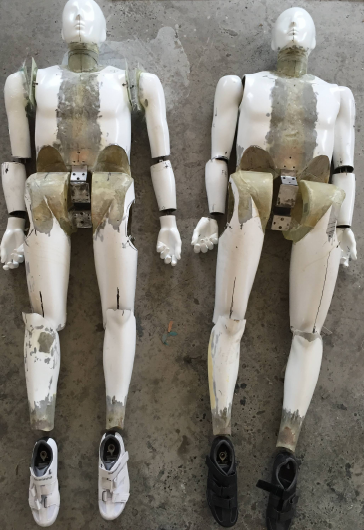
Figure 1. Two full-scale models.